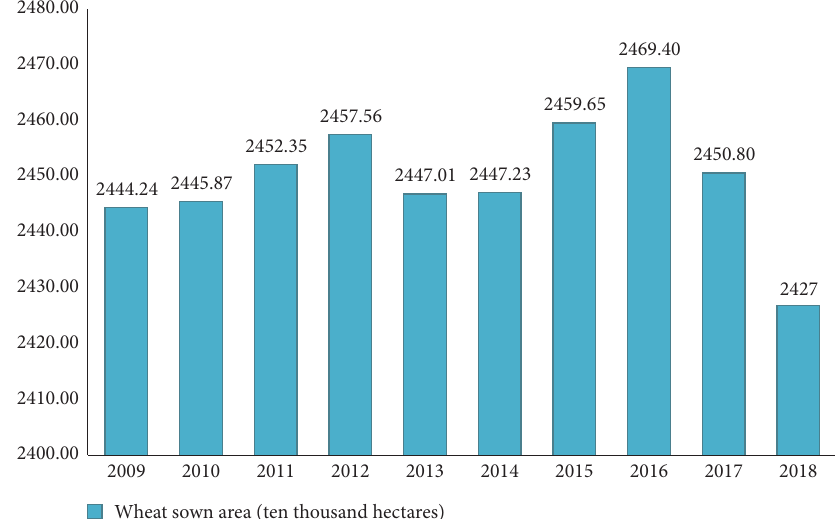
Figure 1: Changes in China’s wheat planting area from 2009 to 2018 (source: National Bureau of Statistics).